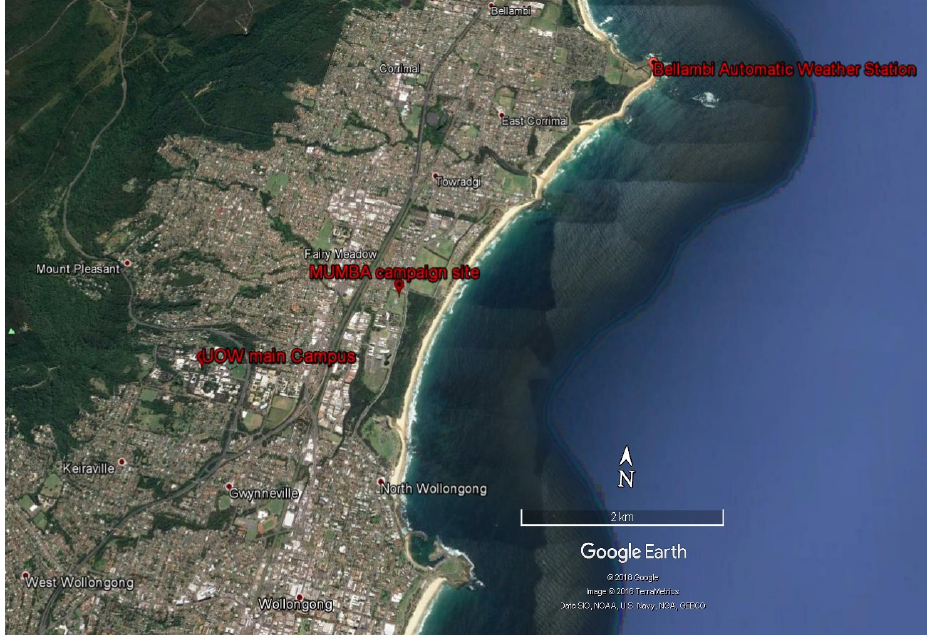
Figure 1. Map of the Measurements of Urban, Marine and Biogenic Air (MUMBA) campaign site, Bellambi Automatic Weather station and University of Wollongong (UOW) main campus. The west and east directions of the MUMBA campaign site were forest and ocean environments,